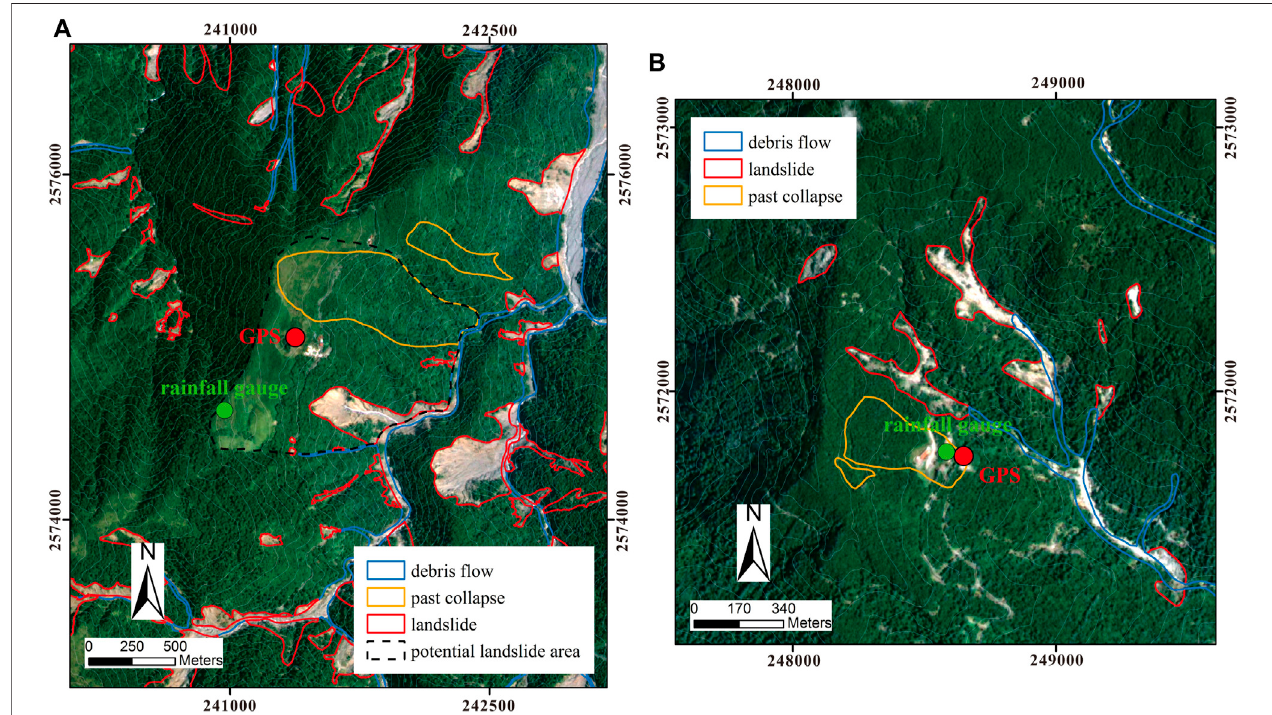
FIGURE2| Birds-eyeviewsofthe (A) TienChihand (B) SiangYanglandslideareas.Theaerophotosaretakenintheyear2010.TherainfallandGPSstationsusedin thepresentanalysisaremarked,andthelandslidescarsanddebris fl owcoursesareoutlined. ThecodenamesoftheGPSstationsareTENCandSYANfortheTienChih and SiangYang areas,